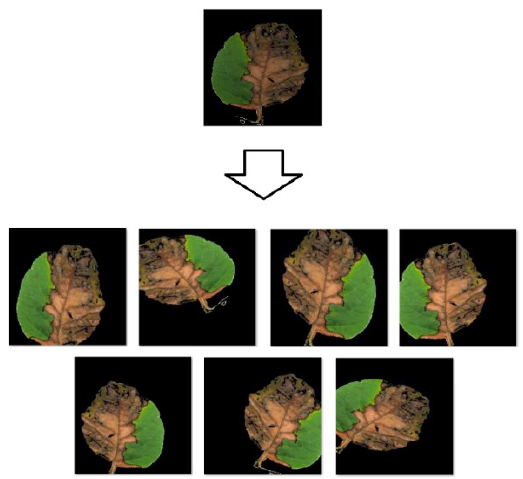
Figure 4. Input image and output images of the data augmentation algorithm.